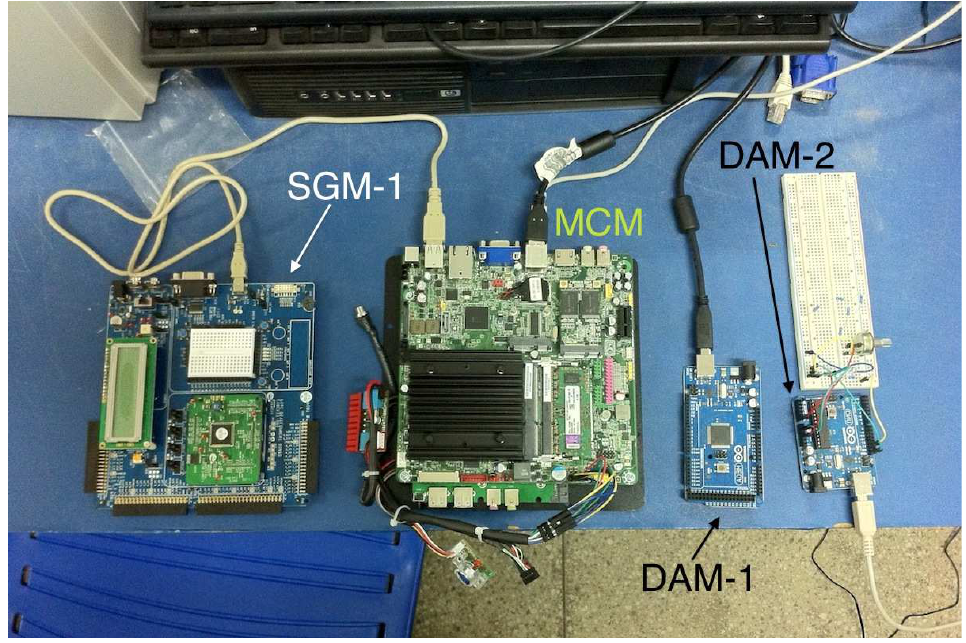
Prototype RTSDS composed of main control module (MCM) data (Intel DN2800MT Mini-ITX), two acquisition modules (DAMs) (Arduino Mega 2560 kit) and a signal generation module (SGM) (PSOC CY8CKIT-001